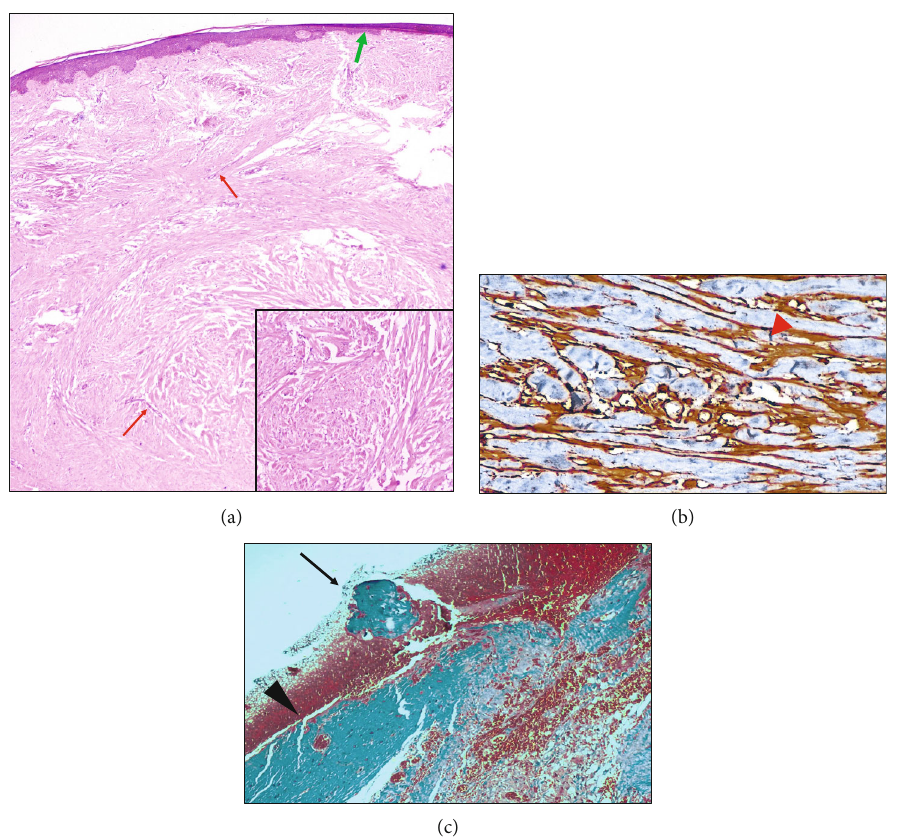
Figure 3: (a) Histopathology showing stretched out epithelium (green arrow), paucicellular thick collagen bundles, and few widely scattered blood vessels (red arrows) (hematoxylin-eosin stain-HE, 4x). Inset shows disorganised, large, hyalinised collagen fi bres (HE, 20x). (b) TGF- β marker shows focal positivity (red arrowhead) in the interstitium suggesting active fi broblast activity (Immunohistochemistry, 40x). (c) Thick collagen bundles (black arrowhead) with a nodule of thick collagen fi bres (black arrow) at the margin of the lesion (Masson- trichome stain,